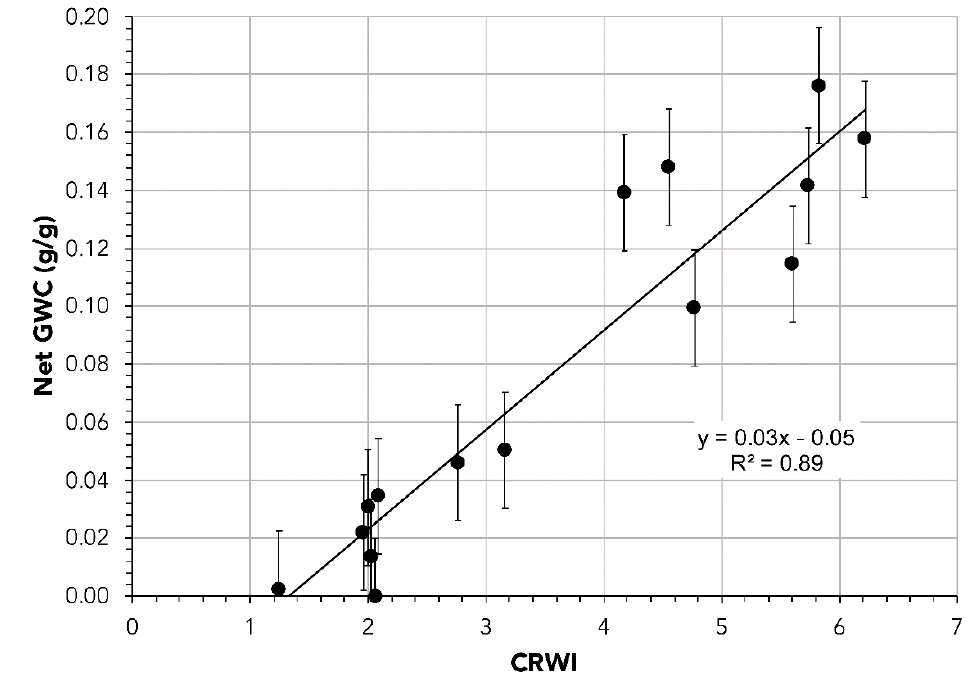
Figure 10. Ground control sampling point water content versus continuum removed water index (CRWI). In this formulation, soil net GWC can be predicted using drone-derived CRWI. Error bars show 95% confidence interval for GWC determined via CRWI analysis.